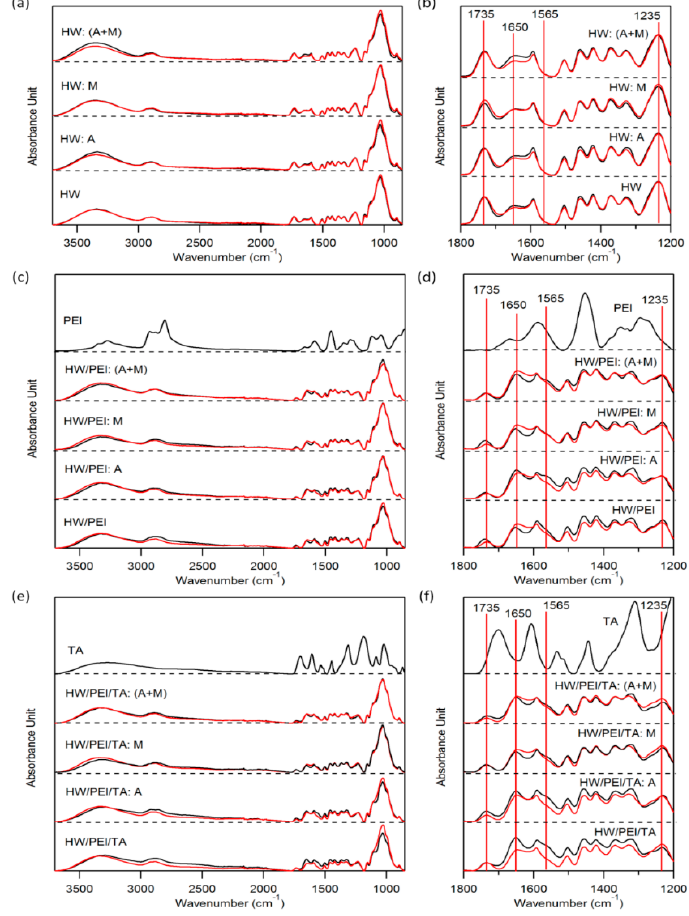
Figure 7. FT-IR absorbance spectra for HW, HW / PEI and HW / PEI / TA before (black) and after (red) ECAP. Figure 7 . FT-IR absorbance spectra for HW, HW/PEI and HW/PEI/TA before (black) and after (red) ECAP.